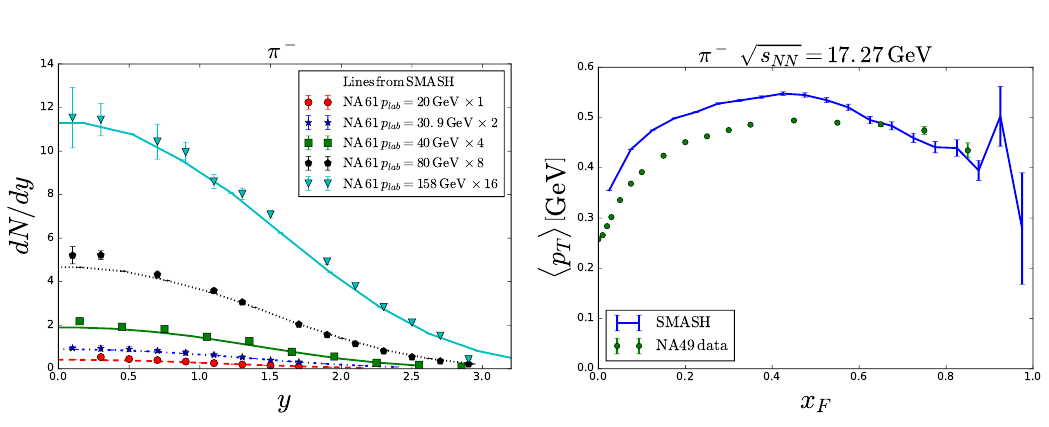
√ s = 17.27GeV compared to experimental